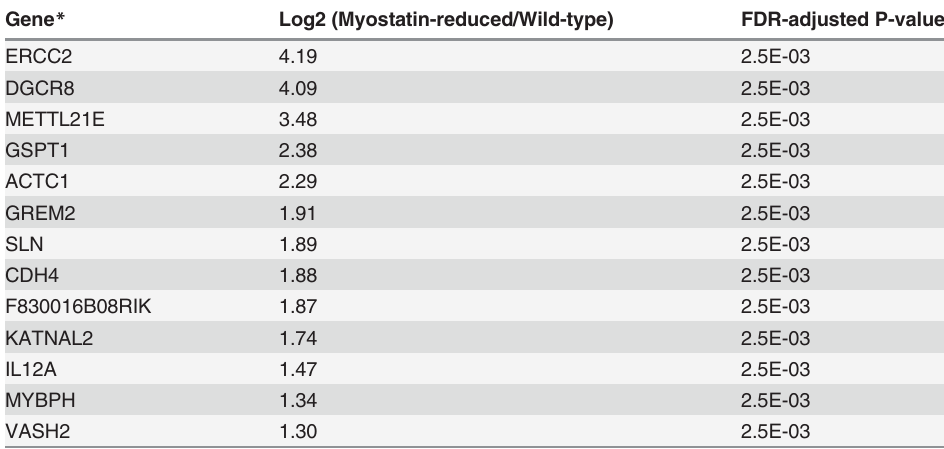
Table 7. Genes differentially expressed (FDR-adjusted P-Value < 0.005 and log2(fold change) > |1.3|) between myostatin-reduced and wild-type mice in the skeletal muscle. Gene *